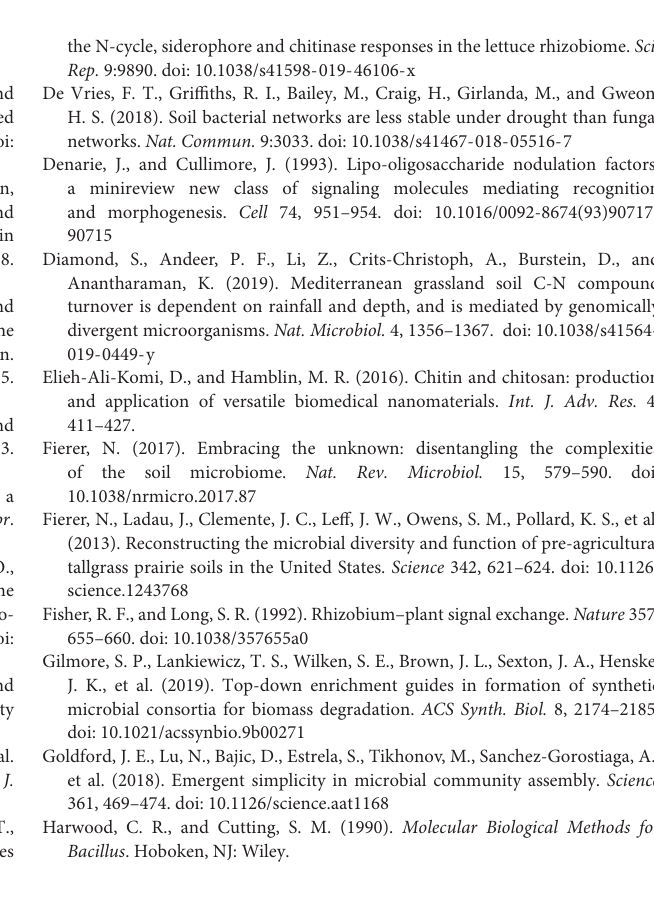
FIGURE S1 | Respiration of native soil with chitin. Respiration levels of native soil grown in dark at 20 ◦ C for several months is indicted. The orange line represents respiration levels with no chitin added. The gray line represents respiration with chitin added to 10 ppm. The yellow line represents respiration with chitin added to 50 ppm. The blue line represents respiration with chitin added to 100 ppm. Error bars indicate standard deviation. FIGURE S2 | Reconstitution of consortia. Phylum level representation of each consortium is shown for the original parent consortia after 22 weeks on plates (Original), and in each of 4–5 glycerol or lyophilized stocks. FIGURE S3 | Reconstitution of consortia. Class level representation of each consortium is shown for the original parent consortia after 22 weeks on plates (Original), and in each of 4–5 glycerol or lyophilized stocks. FIGURE S4 | Reconstitution of consortia. Order level representation of each consortium is shown for the original parent consortia after 22 weeks on plates (Original), and in each of 4–5 glycerol or lyophilized stocks. FIGURE S5 | Parent/stock comparisons of consortia for glycerol storage. Bray-Curtis distance is on the y-axis for the reconstituted stock, the parent community and the distance from the other six parent communities. A star indicates NOT significantly different from the reconstituted stocks ( p -value > 0.05). FIGURE S6 | Parent/stock comparisons of consortia for lyophilization storage. Bray-Curtis distance is on the y-axis for the reconstituted stock, the parent community and the distance from the other six parent communities. A star indicates NOT significantly different from the reconstituted stocks ( p -value > 0.05). FIGURE S7 | Reconstitution of Generation 2 of consortia. Consortia are shown on the x-axis with type shown along the top. Bray-Curtis distances are shown on the